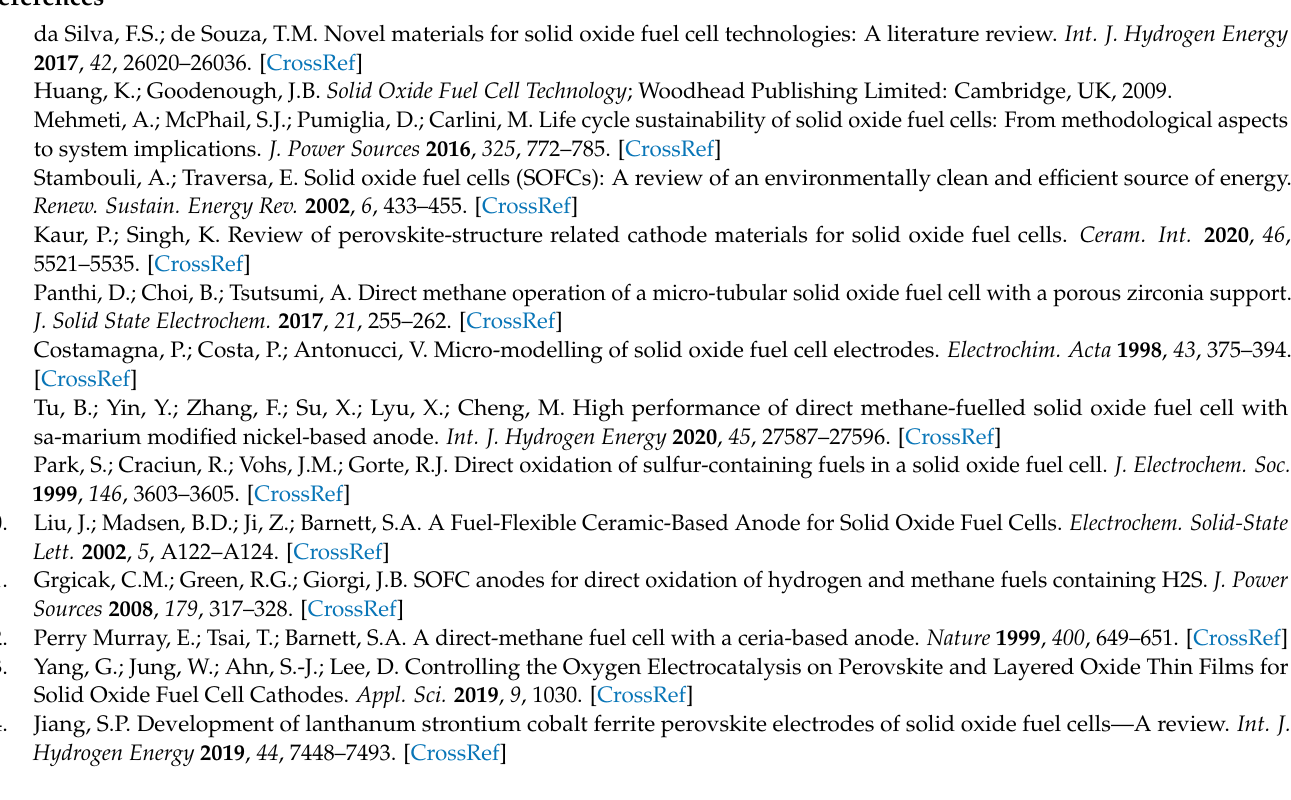
Figure S2: Example of ImageJ diameter location process. The red lines represent the central axes of the nanofibers in one of the segmented images. Figure S3: Fitting curves for the different element lines studied in this work. From top to bottom: O1s, La3d, Sr3d, Mn2p. On the left there are the powders spectra, while on the right those for fibers. Table S1: Fitting parameters of the different studied